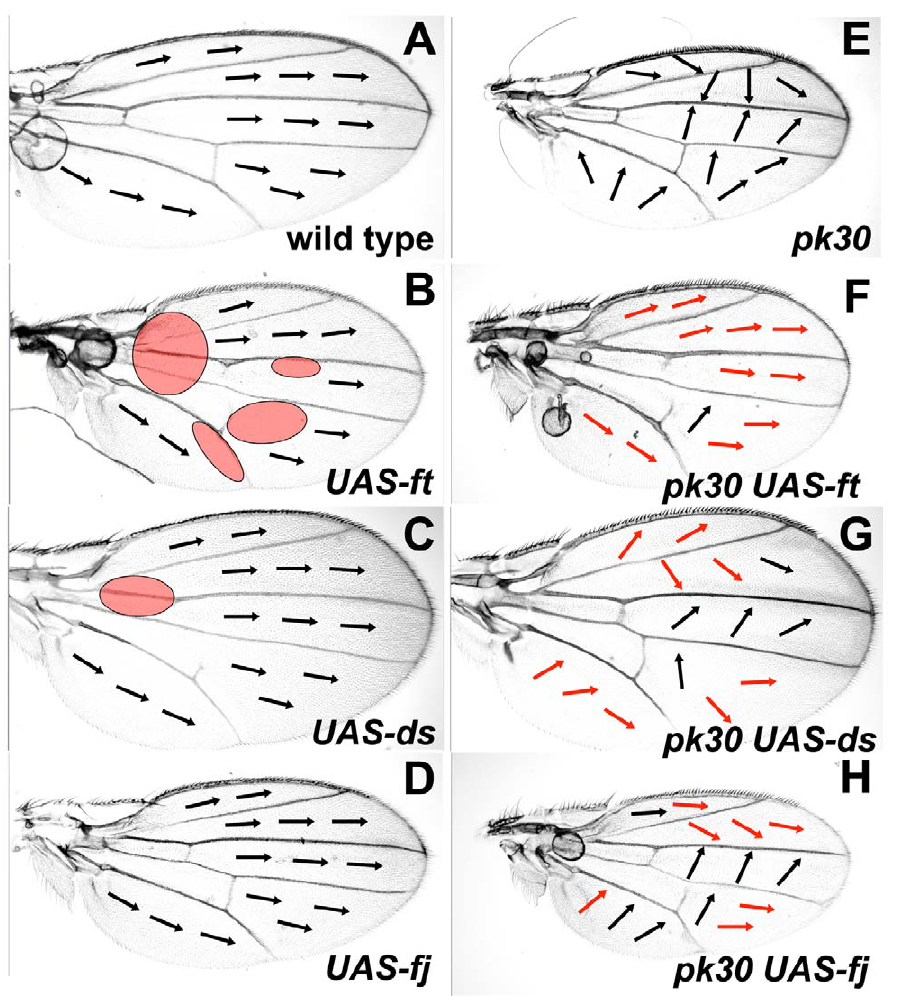
Figure 5. Over-expression of Ft/Ds pathway genes modifies the pk pk hair polarity phenotype. All micrographs are of the female dorsal wing surface. Arrows indicate local hair polarity. Red shaded ovals represent regions where hair polarity differs from wild-type. Red arrows indicate where local hair polarity differs from that seen on a pk pk30 homozygous wing. (A) Wild-type wing. (B) MS1096-gal4 ; UAS-ft wing. (C) MS1096-gal4 ; UAS- ds wing. (D) MS1096-gal4 ; UAS-fj wing. (E) pk pk30 /pk pk30 wing. (F) MS1096-gal4 ; UAS-ft , pk pk30 /pk pk30 wing. (G) MS1096-gal4 ; pk pk30 /pk pk30 ; UAS-ds wing. (H) MS1096-gal4 ; UAS-fj , pk pk30 /pk pk30 wing.